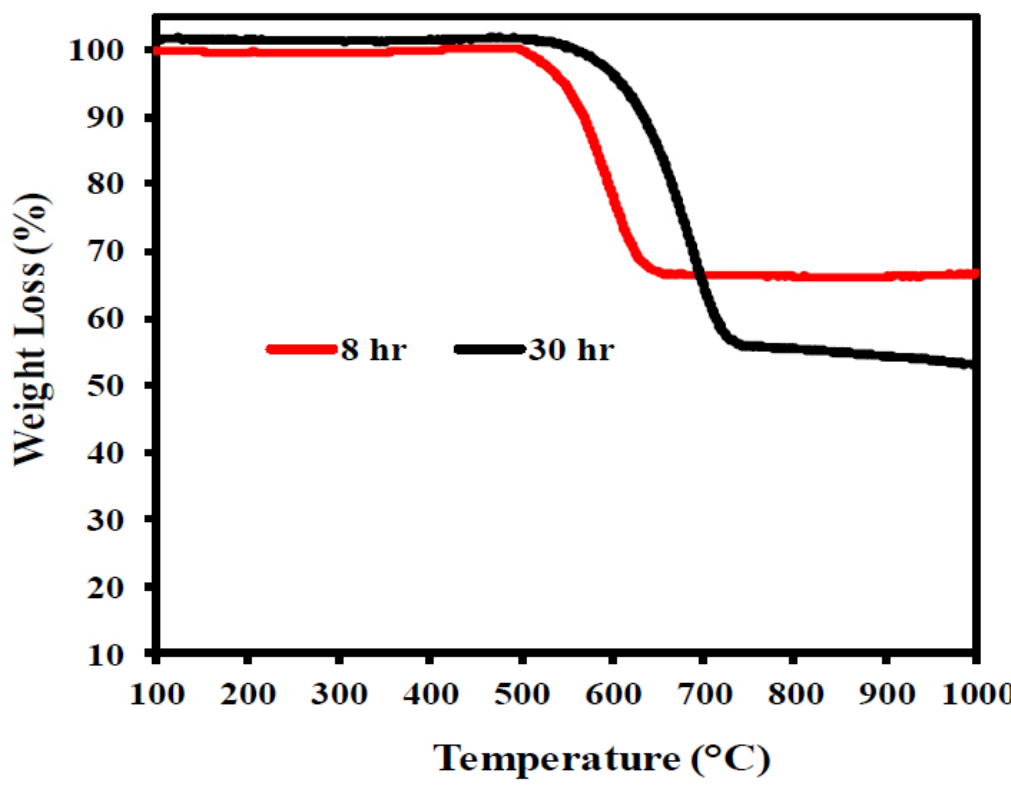
Figure 11. TGA patterns for catalysts, calcined at 725 ◦ C, after 8 h and 30 h reaction times in DRM,